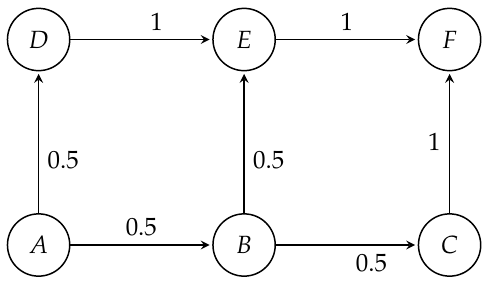
Figure 1. A toy network to illustrate the transport network tomographic